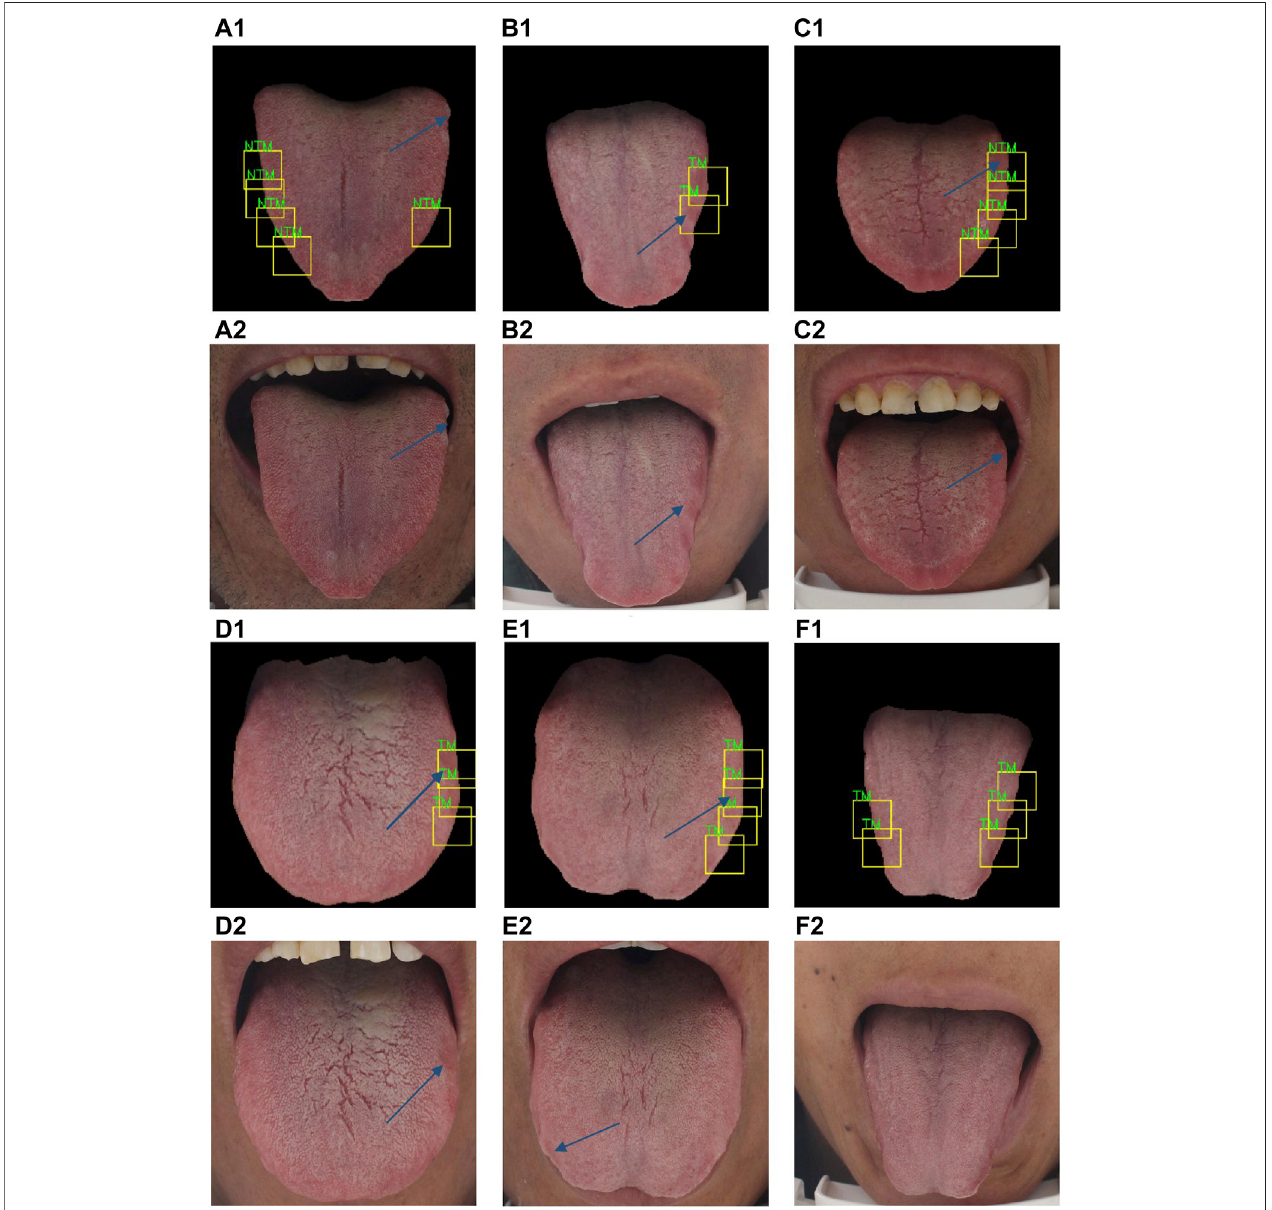
FIGURE 8 | Representative cases of tooth-marked tongue recognition by the proposed method. A2, B2, C2, D2, E2, and F2 are originaltongue images, while A1, B1, C1, D1, E1 and F1 are corresponding prediction results of tooth marks with bounding boxes.